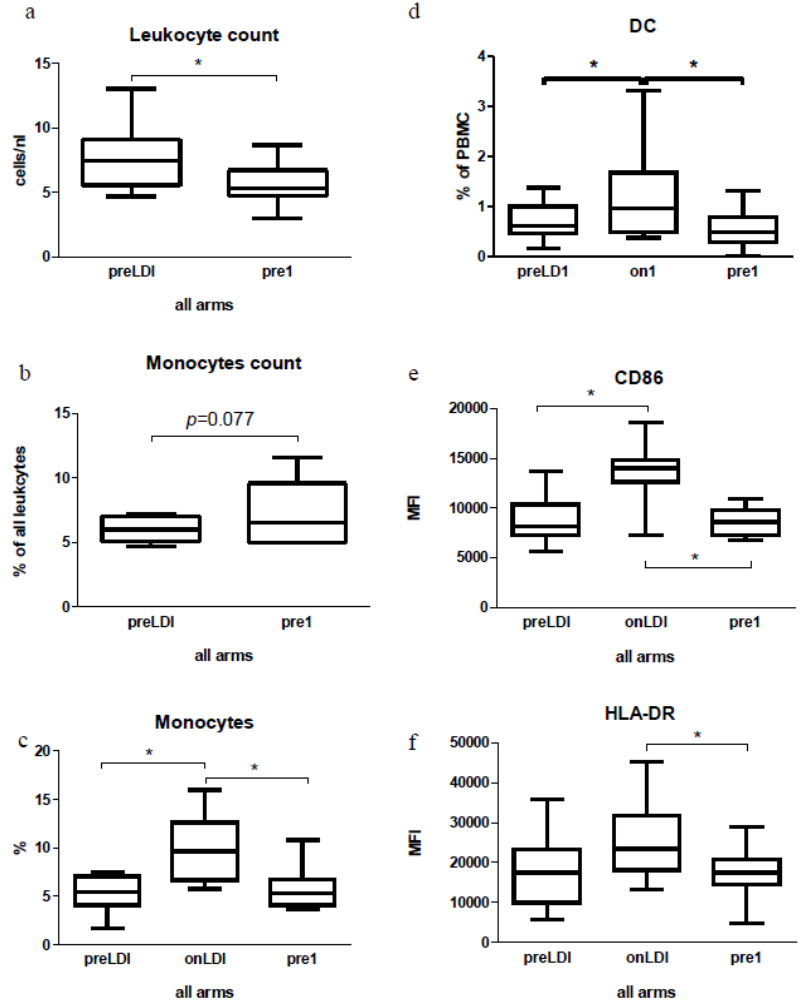
Figure 2. Analysis of leukocytes, monocytes and dendritic cells (DC) in peripheral blood of patients from the CapRI-2 study. ( a ) Absolute amount of leukocytes and ( b ) relative amount of monocytes during the course of IFN therapy (clinical chemistry), no data for onLDI; ( c ) the relative amount of monocytes in total leukocytes during the course of IFN therapy in all patients and in all therapeutic groups; ( d ) DC and their co-stimulatory markers during the course of IFN therapy ( e ) and ( f ). The immunological parameters of 17 patients were analyzed, * p <